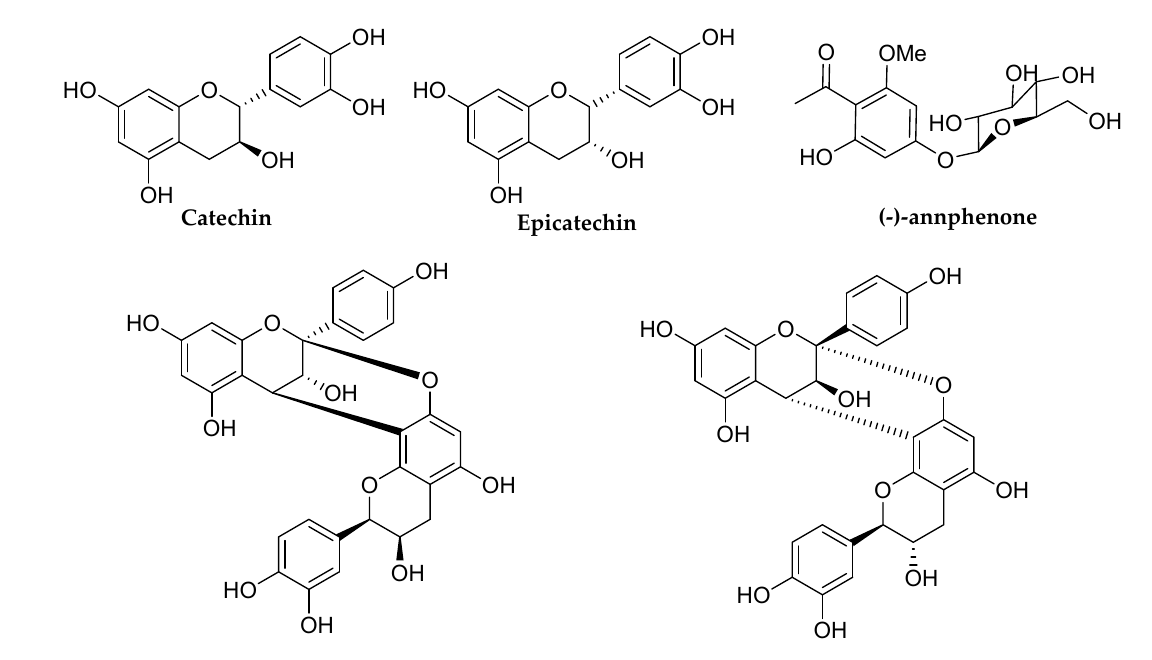
Figure 36. The chemical structures of mentioned flavonoids